Question: In a single sentence, describe what this figure presents.
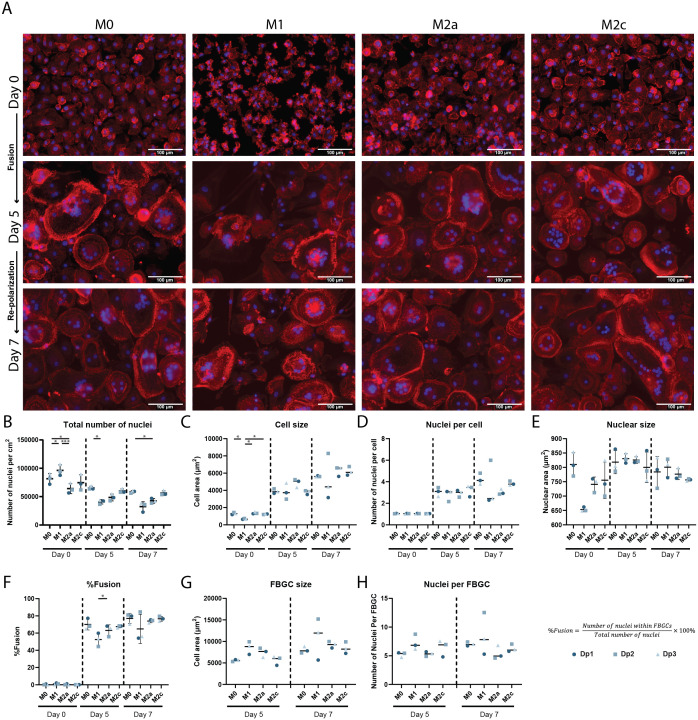
Answer: Foreign body giant cell (FBGC) formation quantification. (A) Non-polarized macrophages (M0) or stimulated toward the pro-inflammatory M1 phenotype, the anti-inflammatory M2a phenotype, and the regulatory M2c phenotype were imaged before interleukin-4 (IL-4) stimulation (Day 0), after IL-4 stimulation (Day 5), and after re-polarization (Day 7). Images stained for actin (red) and nuclei (dark blue). 10x magnification, scale bar indicates 100 µm. (B) Total number of nuclei per cm 2 counted using the StarDist plugin for ImageJ on 10 images per sample shown as mean with SD. (C, D) Cell size and nuclei per cell measured manually using ImageJ on 3 parts of randomly selected images per sample, shown as median. (E) nuclear area counted using the StarDist plugin for ImageJ on 10 images per sample shown as mean with SD. (F) Percentage fusion (%Fusion), calculated using the equation shown in the bottom right of figure, with FBGCs classified as a cell with 3 or more nuclei, shown as mean with SD. (G, H) Size and number of nuclei per FBGC measured manually using ImageJ on 3 parts of randomly selected images per sample, shown as median. All data were measured for three different donor pools (Dp1-3; n=3 biological replicates). * p < 0.05.